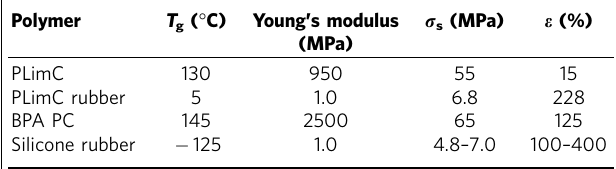
Table 1 | Glass transition temperature and tensile properties of PLimC 22 , PLimC rubber, BPA PC and silicone